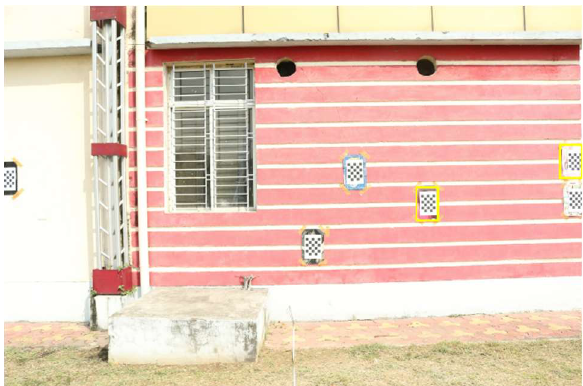
Figure 2. Normal geometry image capturing a building plane